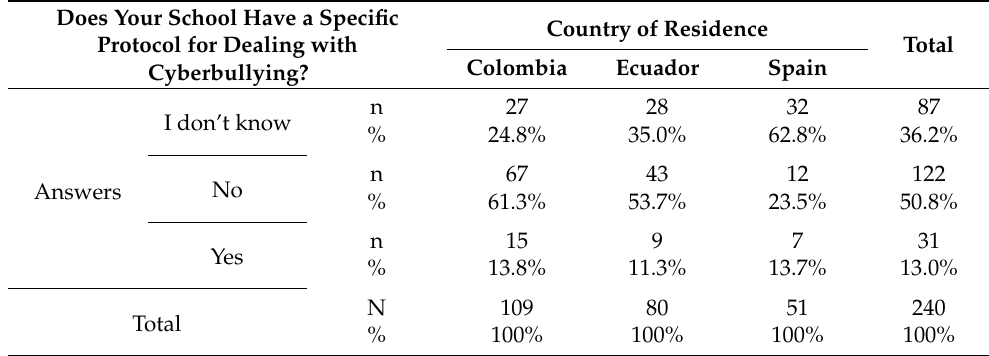
Table 4. Cross-categorization of the variable “Does your school have a specific protocol for cyberbul- lying cases” and the variable “Country of residence”.